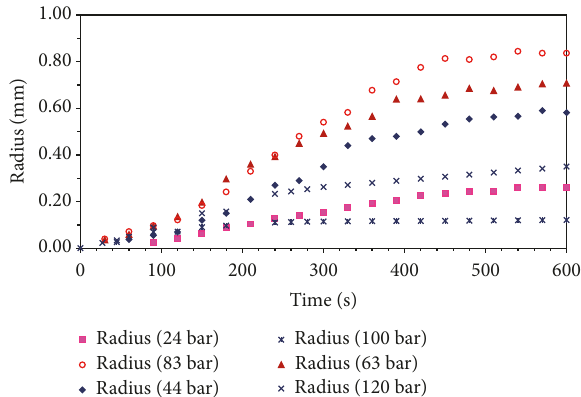
Figure 4: Bubble radius of PS/CO 2 during depressurization after holding at 100 and 120bar at 50 ∘ C for 2 hours.